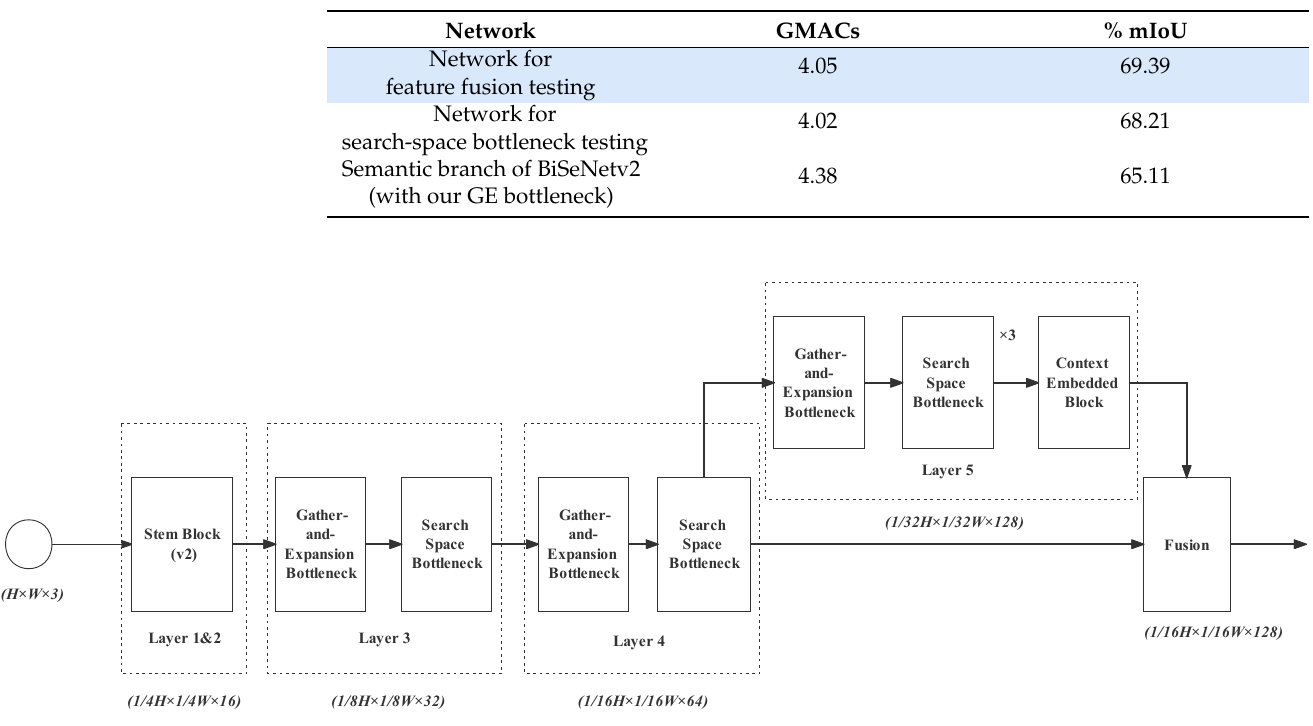
Figure 15. Network for feature fusion testing.